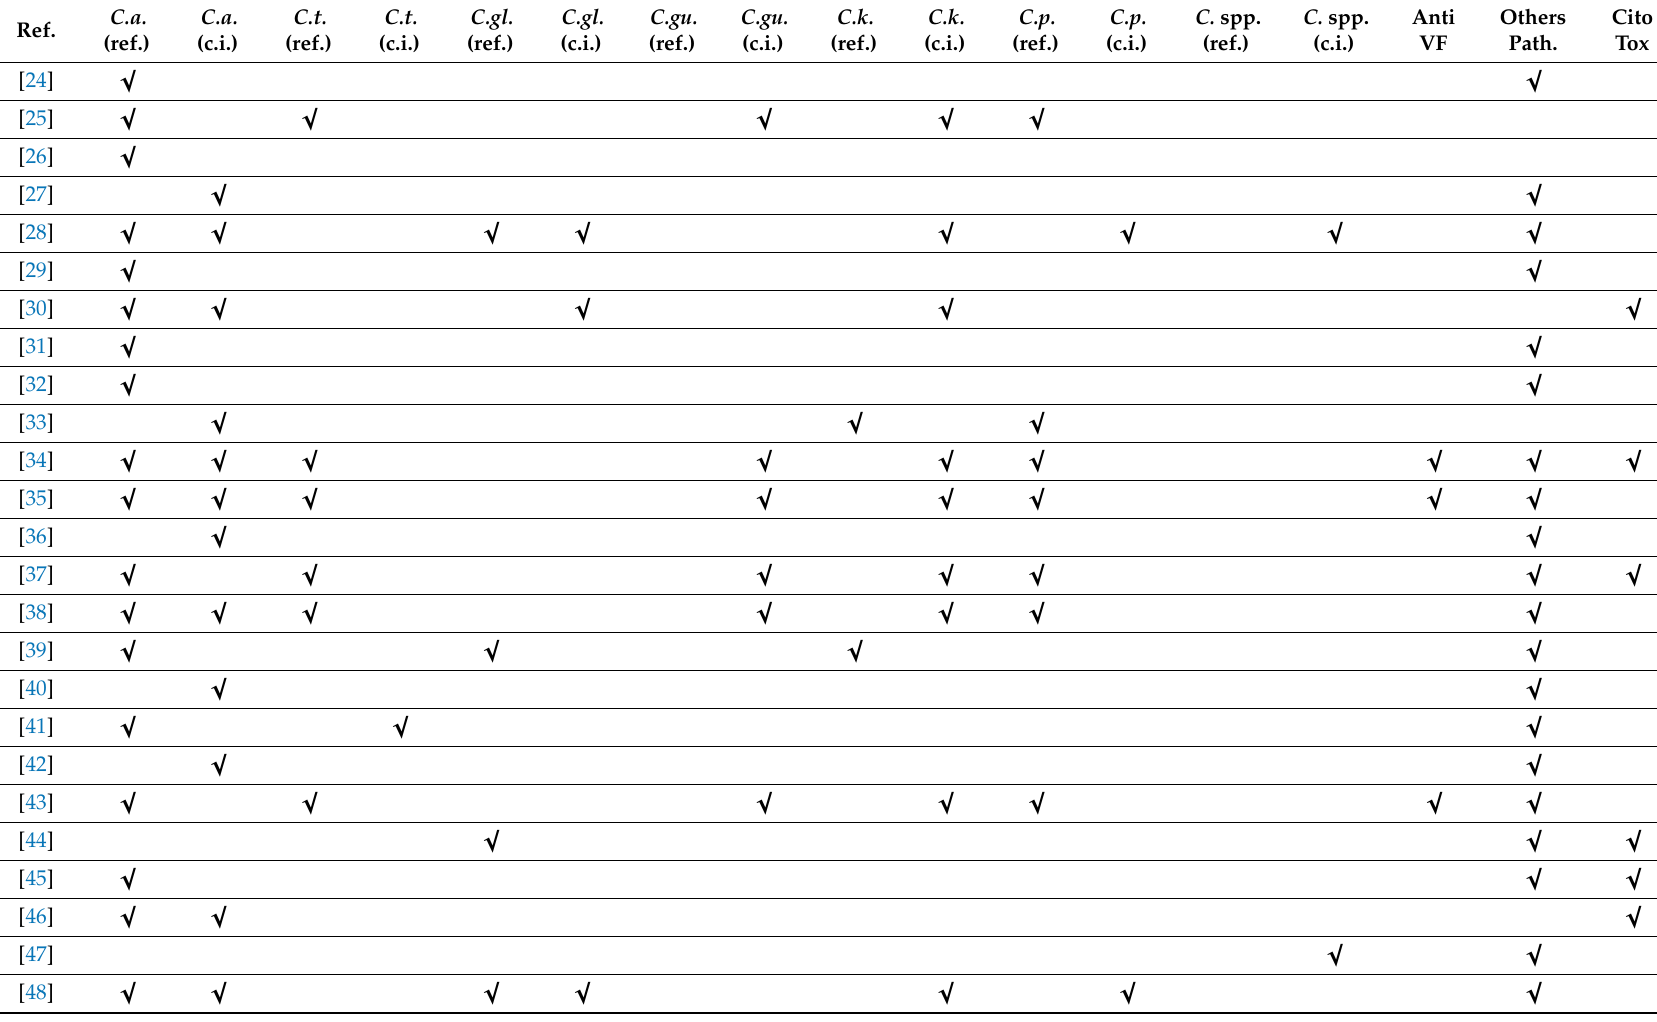
Table 1. General overview of the targeted Candida spp. and other relevant information of the reviewed research papers.